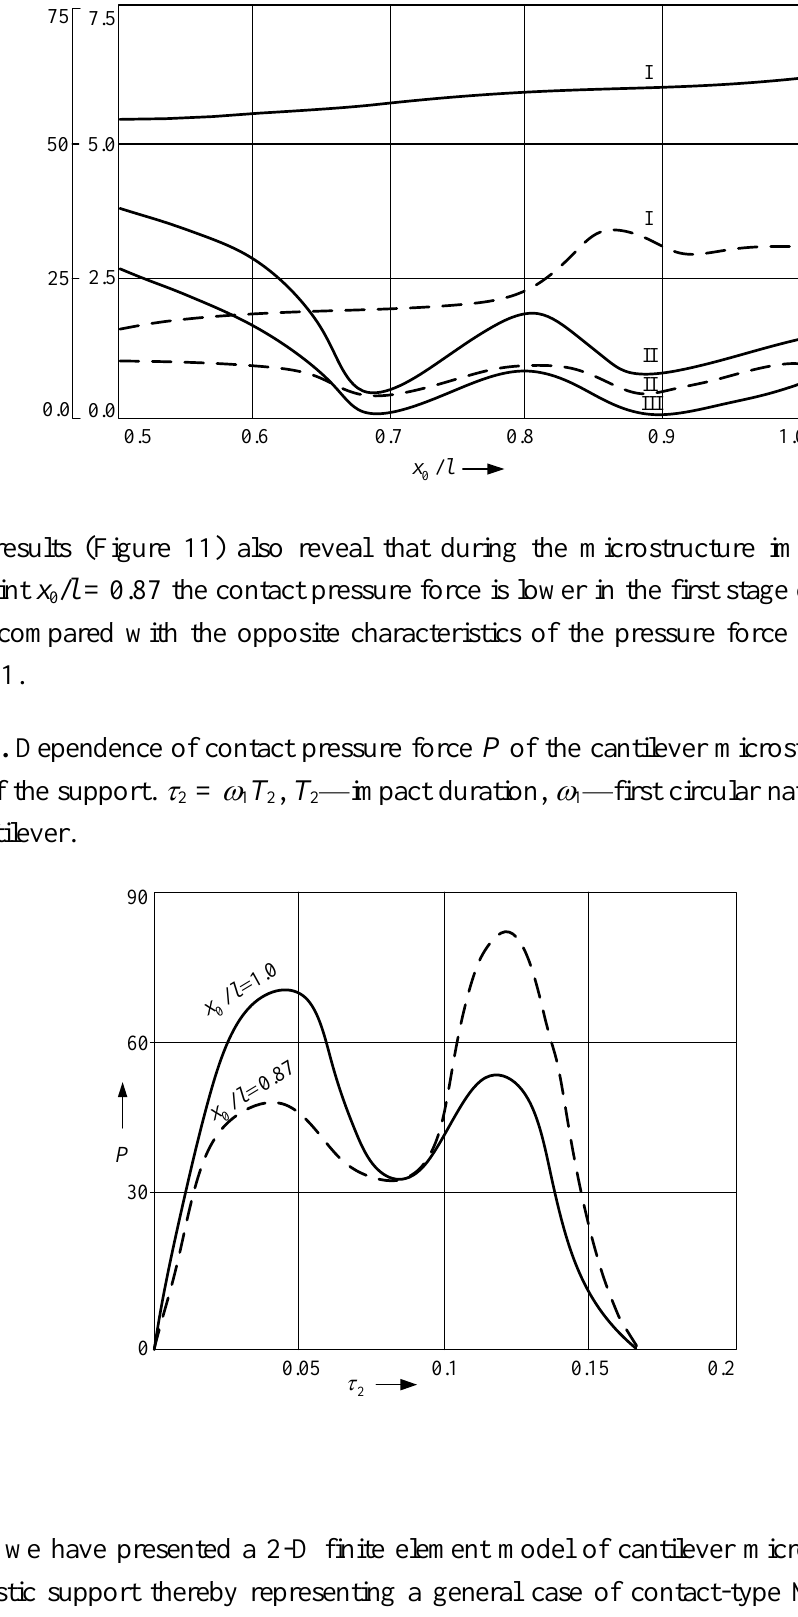
Figure 10. Dependence of impact velocity z' (continuous lines) and contact pressure force P (dashed lines) on the position of the support.